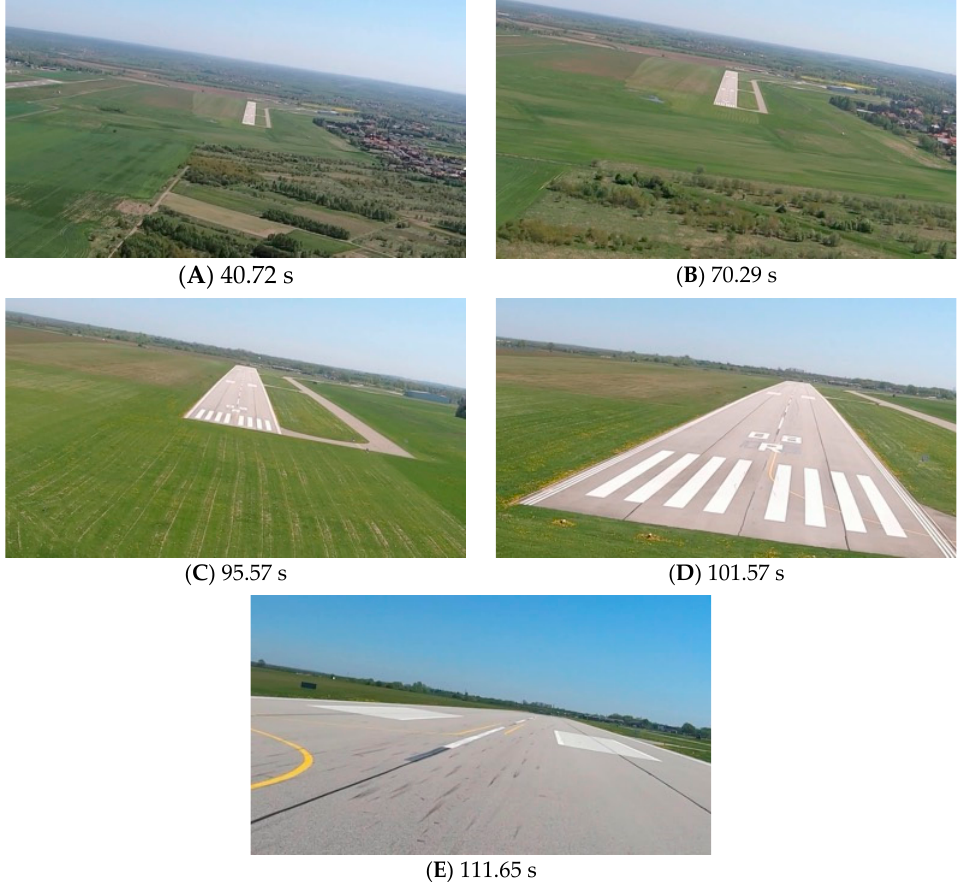
Figure 9. Recorded images related to the altitude measurements presented in Figure 8.